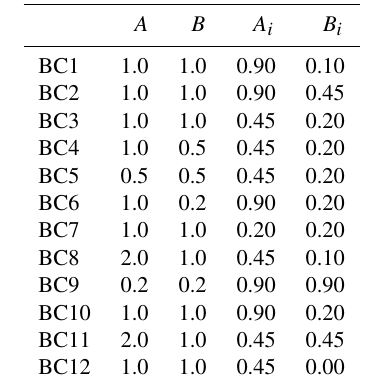
Table 2. Different scavenging parameters of below-cloud and in- cloud scavenging used in the ensemble model simulations for BC. A and B are rain and snow collection efficiencies for below-cloud scavenging; A i is the cloud condensation nuclei efficiency and B i the ice nuclei efficiency that are used in in-cloud scavenging follow- ing Grythe et al.